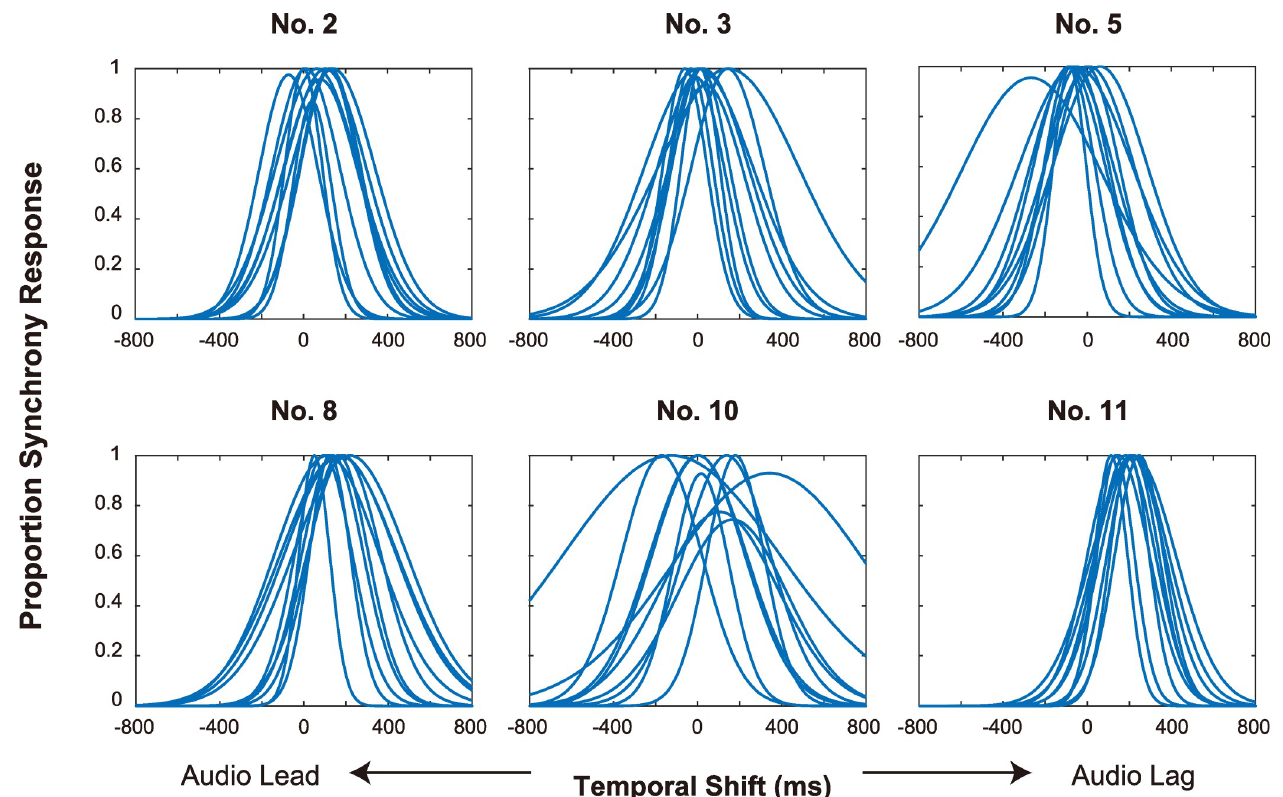
Fig 2. Perceived synchrony distributions in individual participants. Each curve indicates the estimated psychometric function for synchrony perception in an individual participant. These curves are located close to each other, indicating that different participants had similar synchrony perception during observation of the Radio Calisthenics